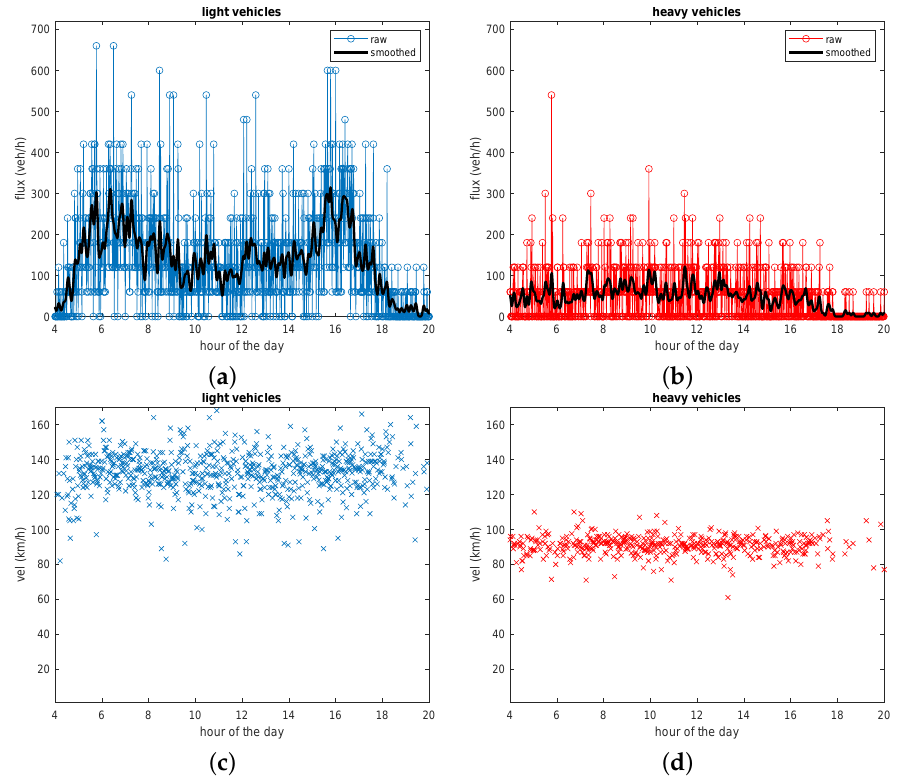
Figure 3. Typical daily (Thursday) flux and velocity data on the A28 motorway of ( a – c ) light and ( b – d ) heavy vehicles collected in May 2019 near Sesto al